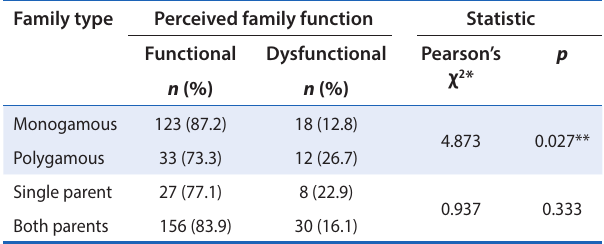
Table 2: Relationship between family function and family type